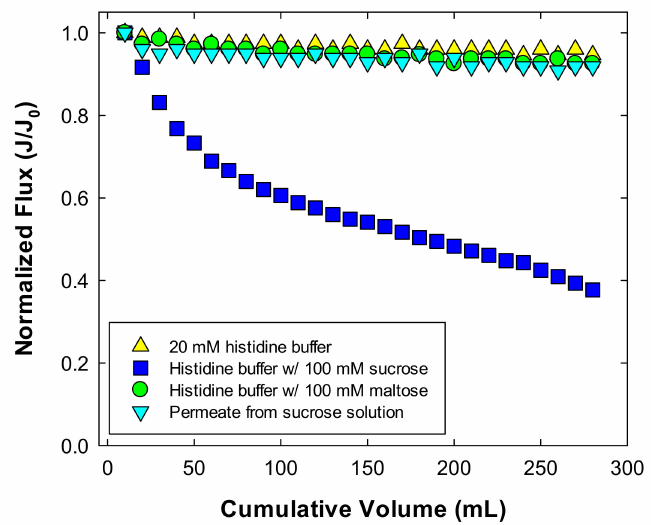
Figure 3. Normalized flux as a function of the filtrated volume during ultrafiltration using the normal flow filtration system at an applied pressure of 100 kPa, with a stirring speed of 800